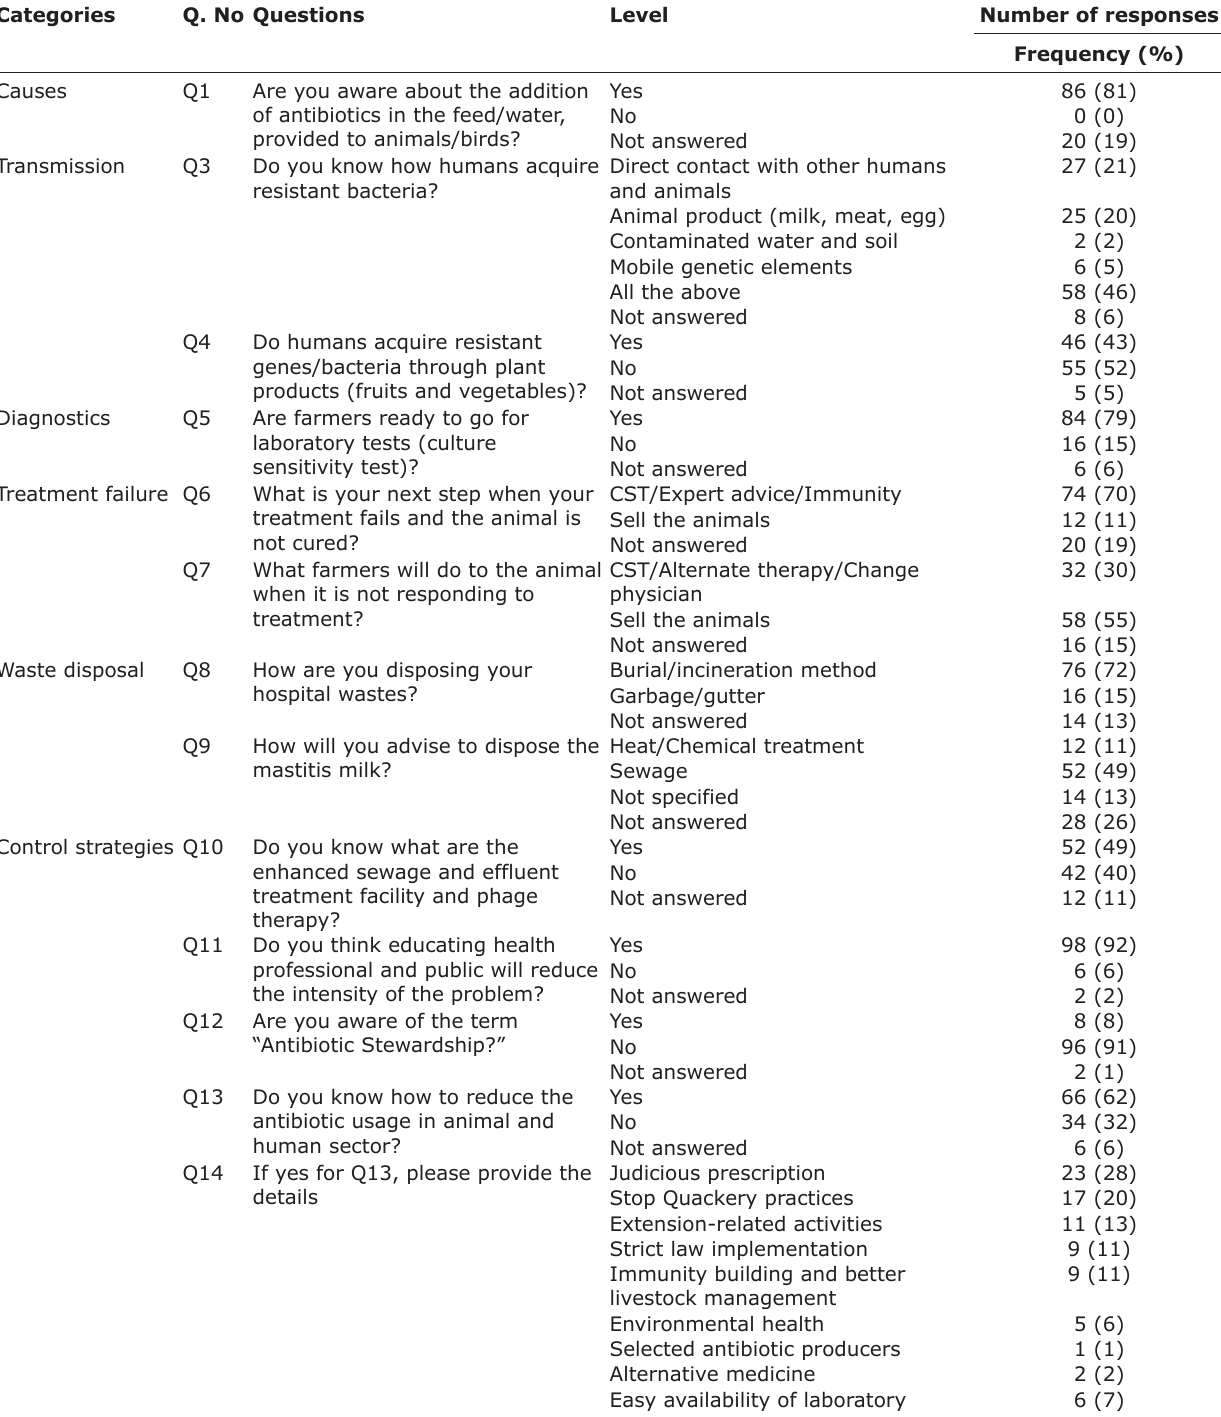
Table-1: Details of questions with their respective options and the responses. Categories